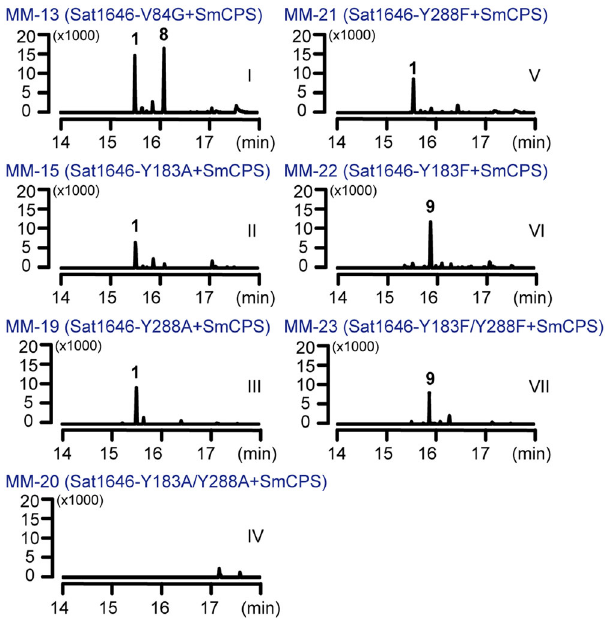
Fig. 4 The GC – MS analysis (extracted ion chromatogram at m/z 272) of different engineered E. coli strains. The Y -axes show the ion